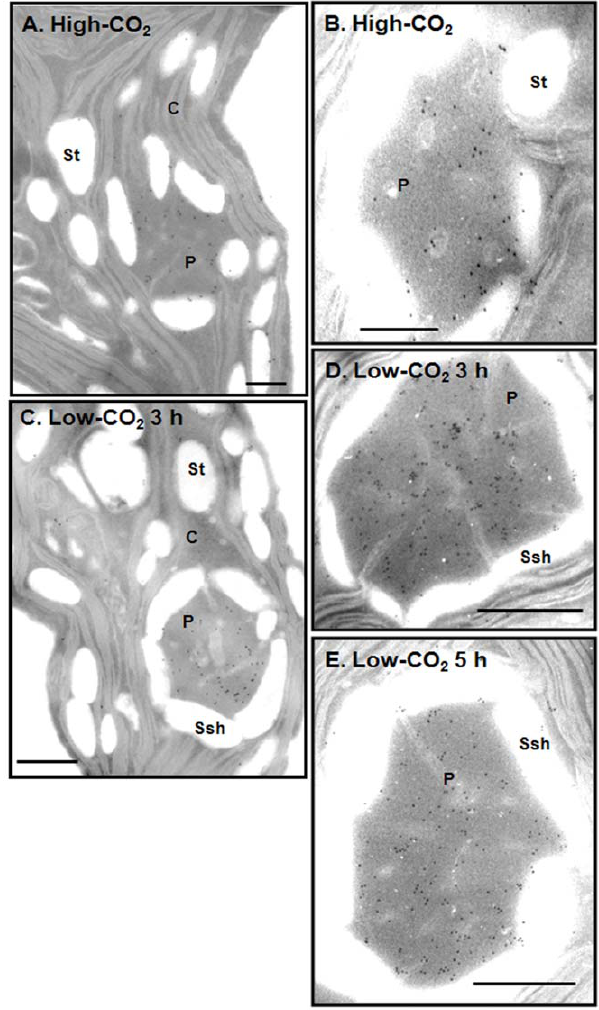
Figure 5. Immunogold labelling of C.reinhardtii cells grown on high-CO 2 or acclimated to low CO 2 conditions for 2 and 5 h. ( A ) and ( B ) High-CO 2 -grown cells probed with affinity-purified antibodies against Cah3. ( C ) and ( D ) Cells acclimated to low CO 2 conditions for 3 h and ( E ) pyrenoid of a cell acclimated to low CO 2 conditions for 5 h, probed with affinity-purified antibodies against Cah3. Bars indicated 0.5 m m. C, chloroplast; P, pyrenoid; Ssh, starch sheath; and St, stroma chloroplast.